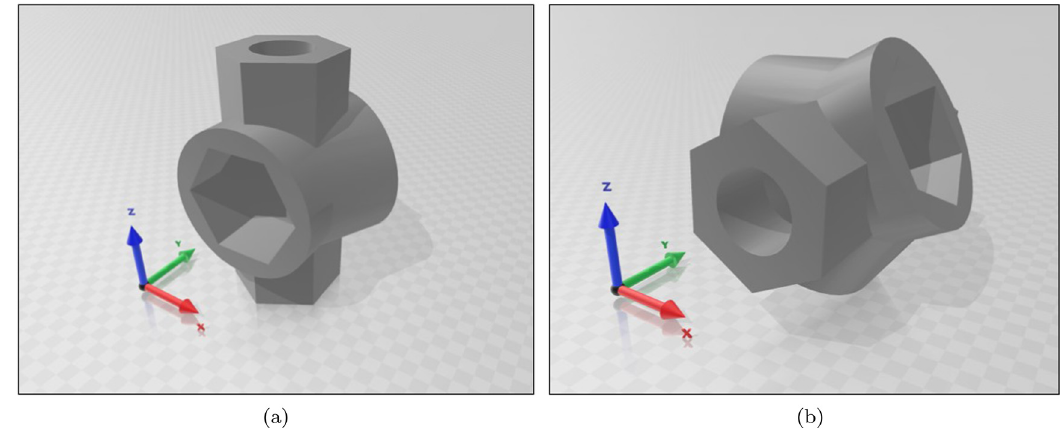
Lower value indicates higher accuracy. Lowest values highlighted in bold.